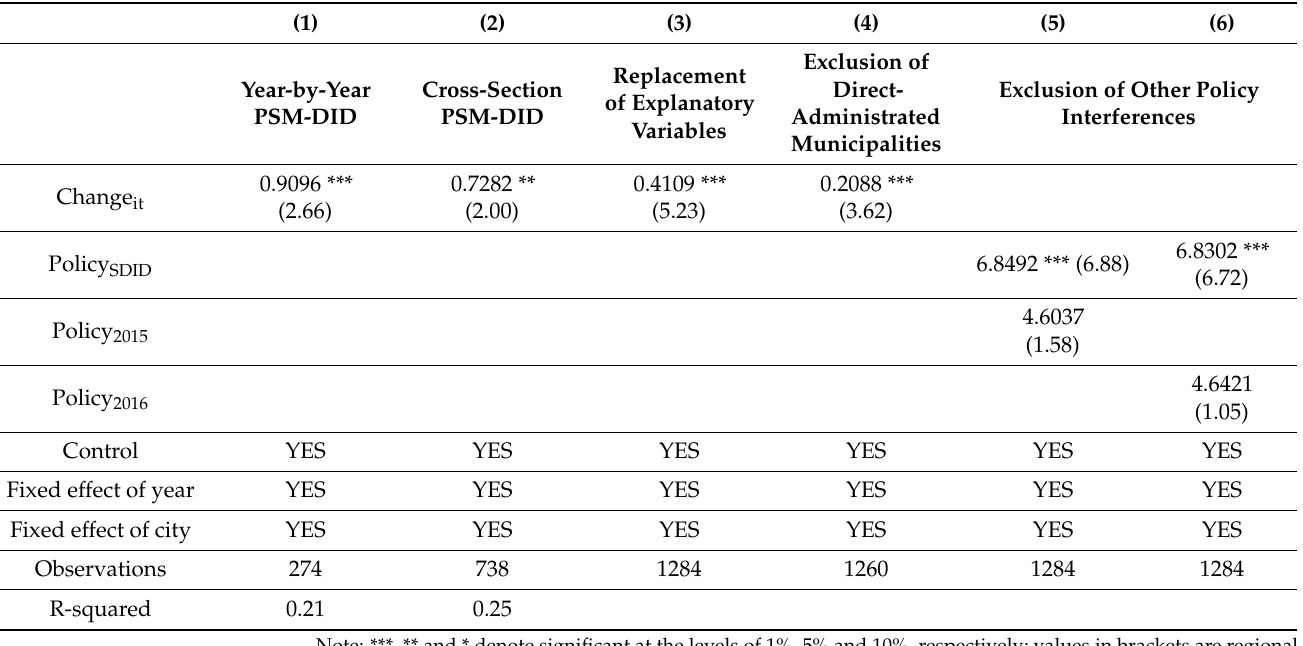
Table 3. Robustness test regression